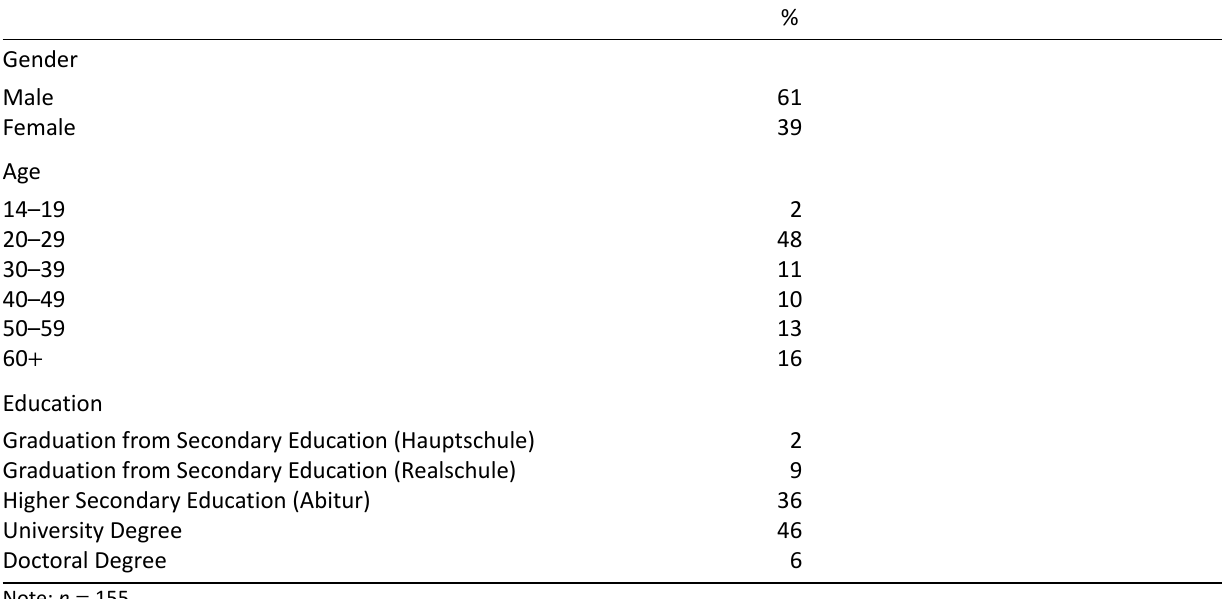
Table 2. Socio-demographic data of